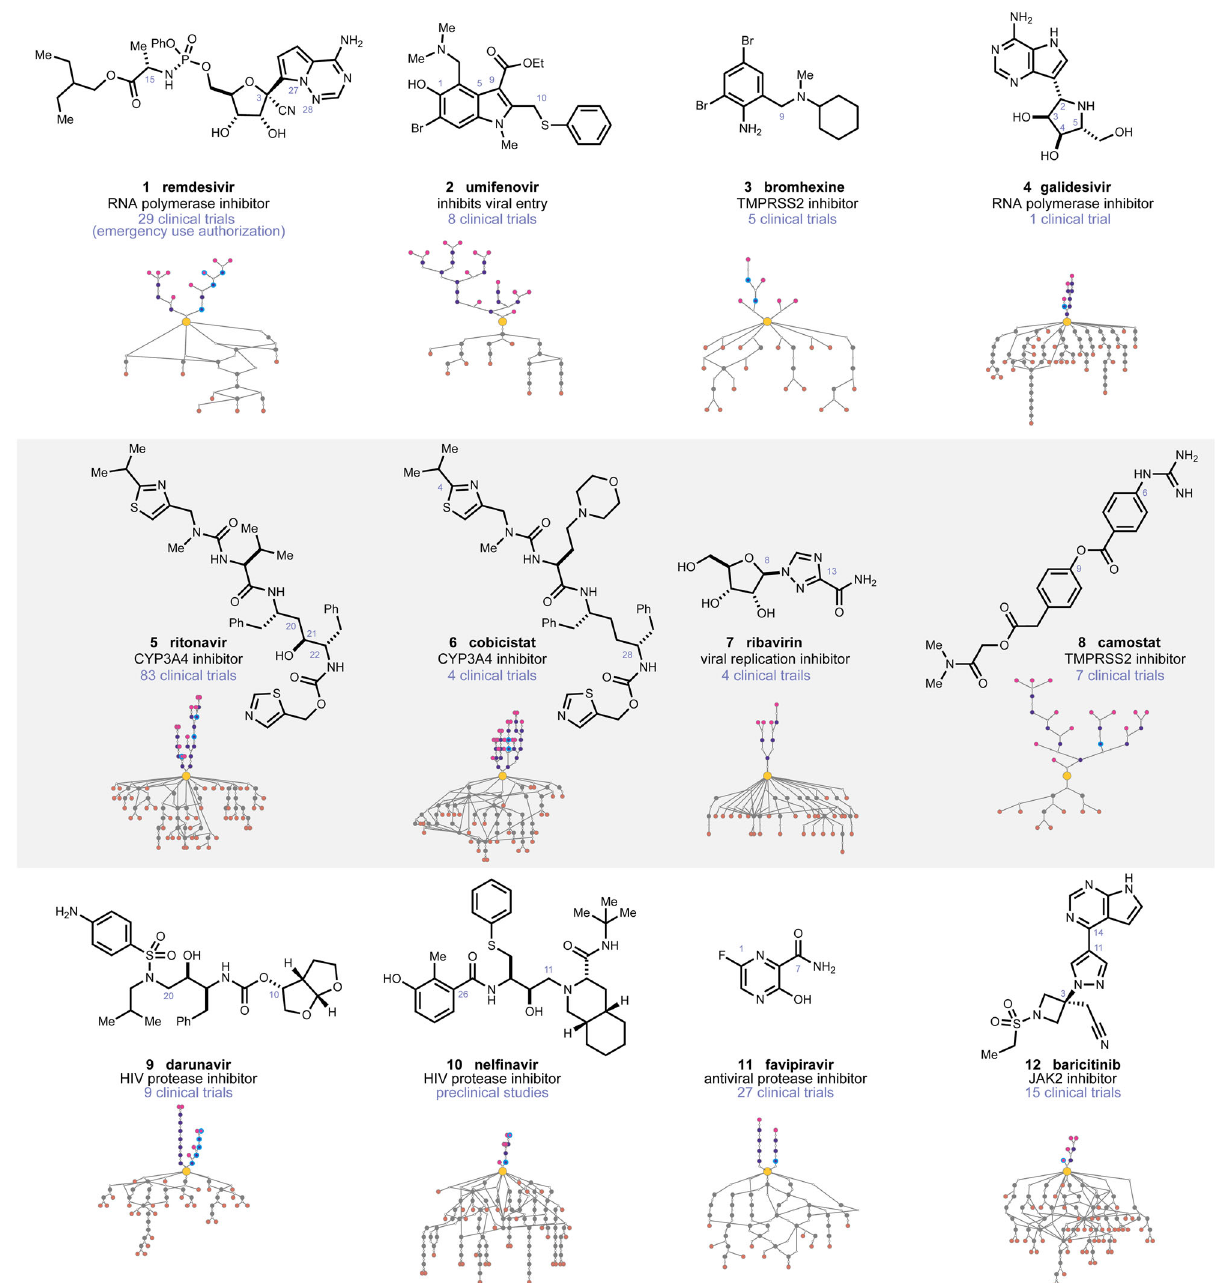
Fig. 2 Therapeutics being evaluated for COVID-19 and their retrosynthetic analysis networks. The number of clinical trials is based on search results for all listed trials, completed, active, or planned, found on www.clinicaltrials.gov (accessed July 7th, 2020). For the route networks, the yellow dot at the center is the target molecule. Routes in grey and orange below the target are published, and the routes in purple and pink above the target are routes predicted. Intersection nodes in literature routes re fl ect common intermediates or starting materials. A version of this diagram is available as an interactive route